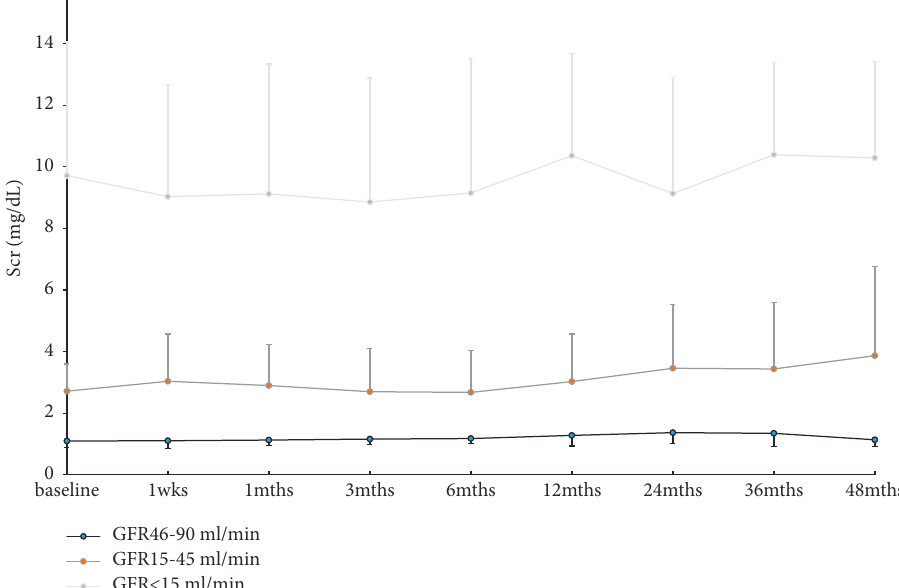
Figure 5: Change of renal function. Note: Scr: serum creatinine and eGFR: estimated glomerular filtration rate hemoglobin